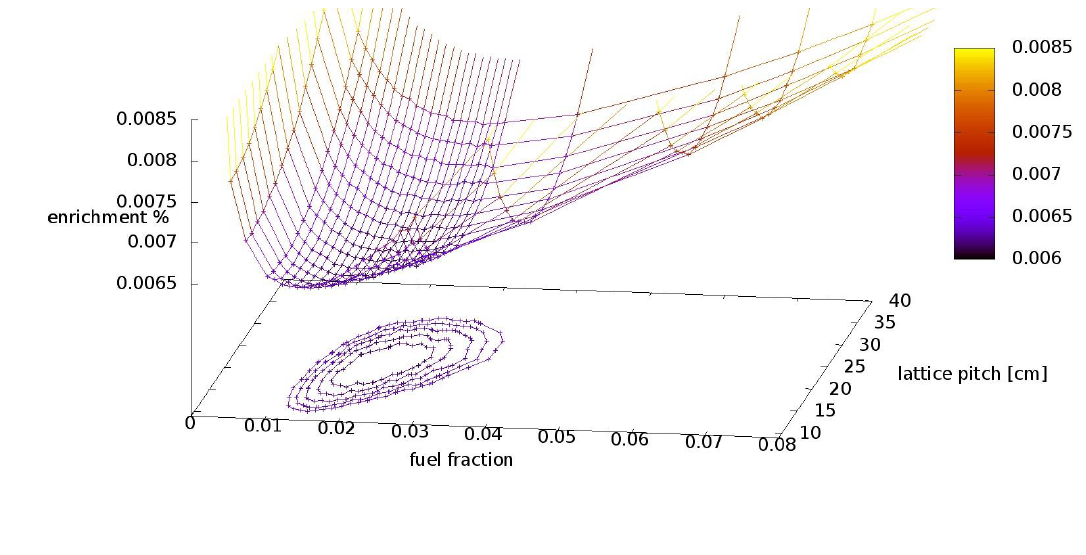
Figure 3. Enrichment vs. lattice pitch vs. fuel fraction for a critical reactor with 2 ppm boron in the graphite. The 2-ppm contamination level would allow a reactor with a lattice pitch, fuel radius, and fuel fraction similar to the British Windscale Piles and Calder Hall designs to reach criticality-using uranium containing at least 0.65% 235